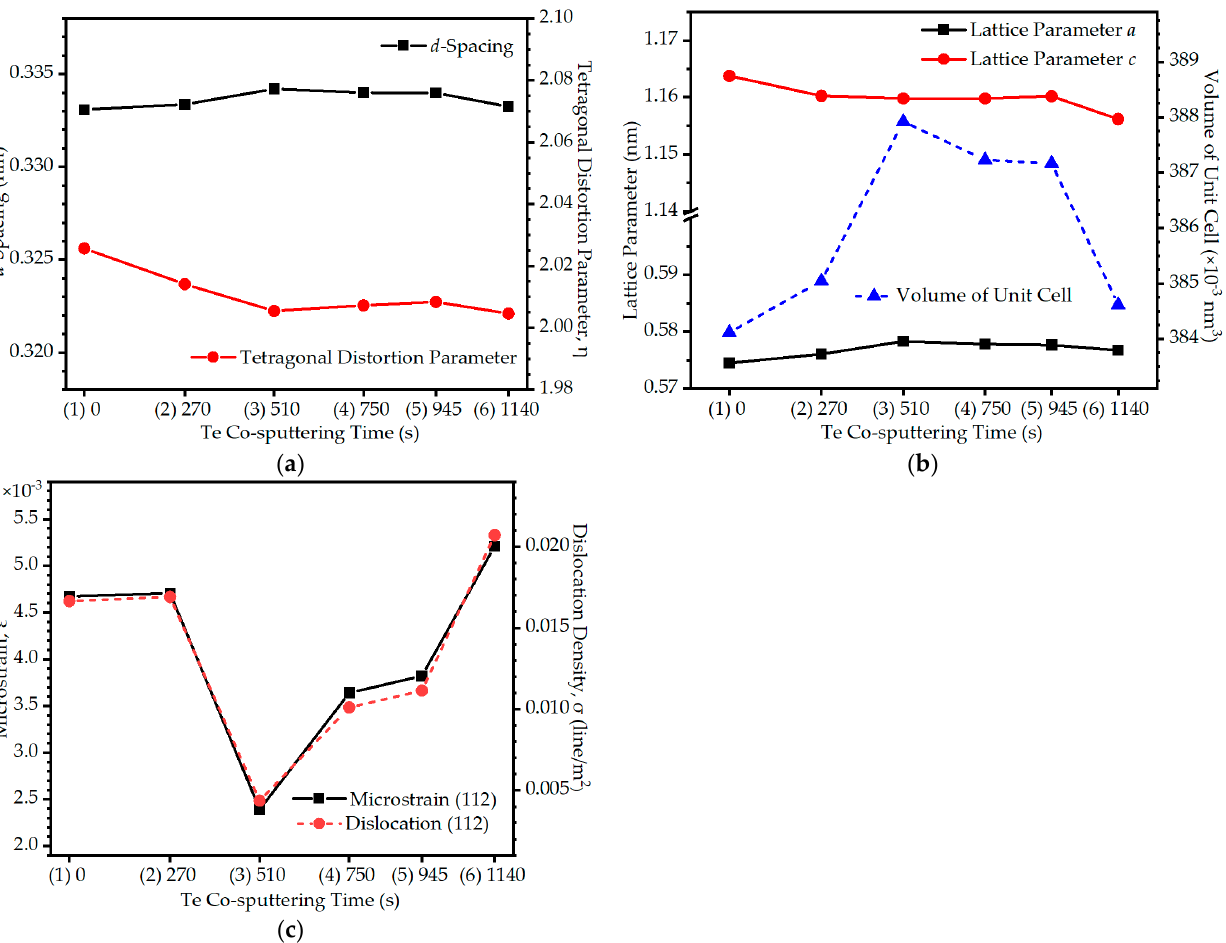
Figure 4. Lattice characteristics of the CIGS:Te thin films with different Te co-sputtering times of (1) 0, (2) 270, (3) 510, (4) 750, (5) 945, and (6) 1140 s. ( a ) Tetragonal distortion parameter ( η ) and d -spacing along the (112) plane; ( b ) lattice constants, a and c , and volume of unit cell; ( c ) microstrain ( ε ) and dislocation density ( δ ).